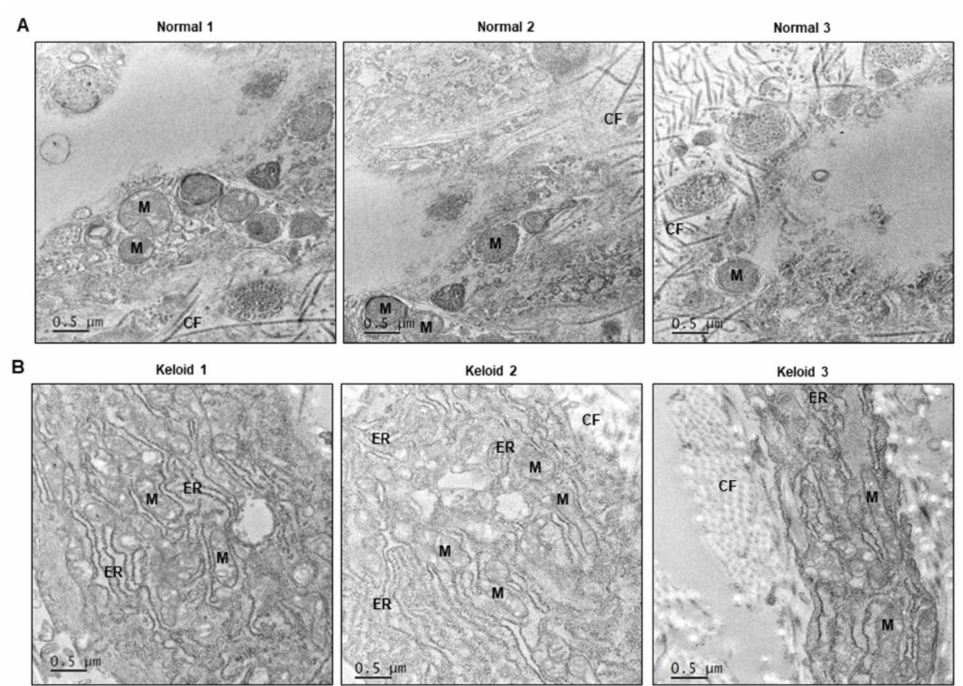
Figure 3. Transmission electron micrographs (EM) of normal skin ( n = 3) and keloid tissues ( n = 3). ( A ) Representative EM images of normal skins. ( B ) Representative EM images of keloid tissues. ER, Endoplasmic Reticulum; M, Mitochondira; CF, collagen fiber; N, Nuclues. Scale bar: 0.5 µ